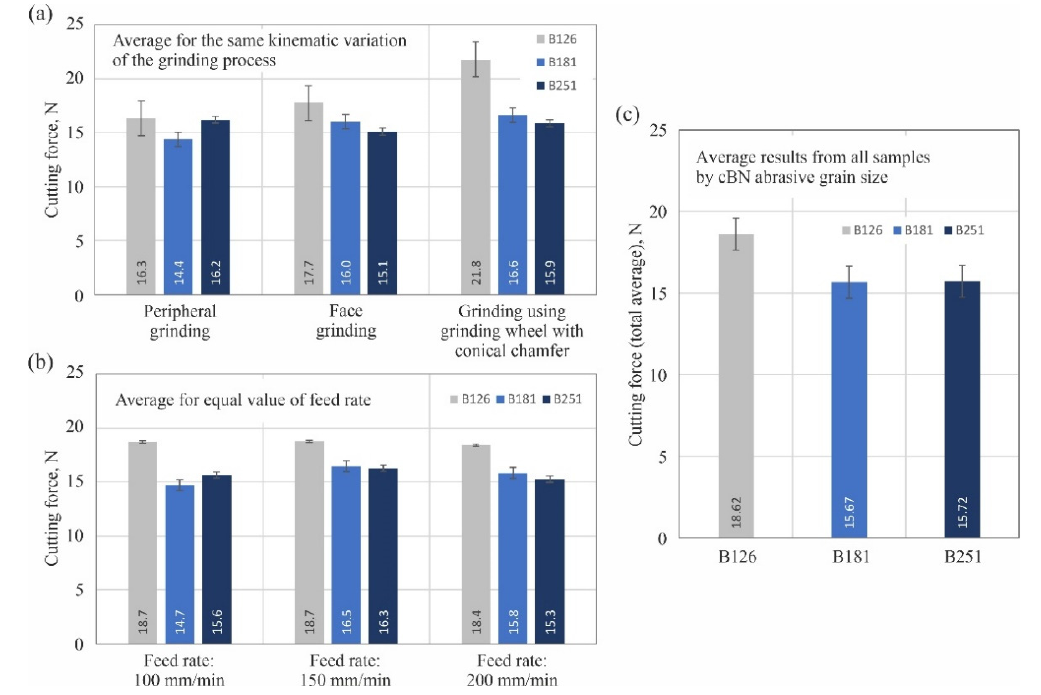
Figure 9. Average cutting force values determined from measurements of blades shaped using grinding wheels with cBN abrasive grains numbered B126, B181 and B251: ( a ) for the same kinematic variation of the grinding process; ( b ) for equal value of feed rate v f ; ( c ) average results from all samples by cBN abrasive grain size (error bars represent the standard error equal to the standard deviation σ divided by the square root of the total number of samples).